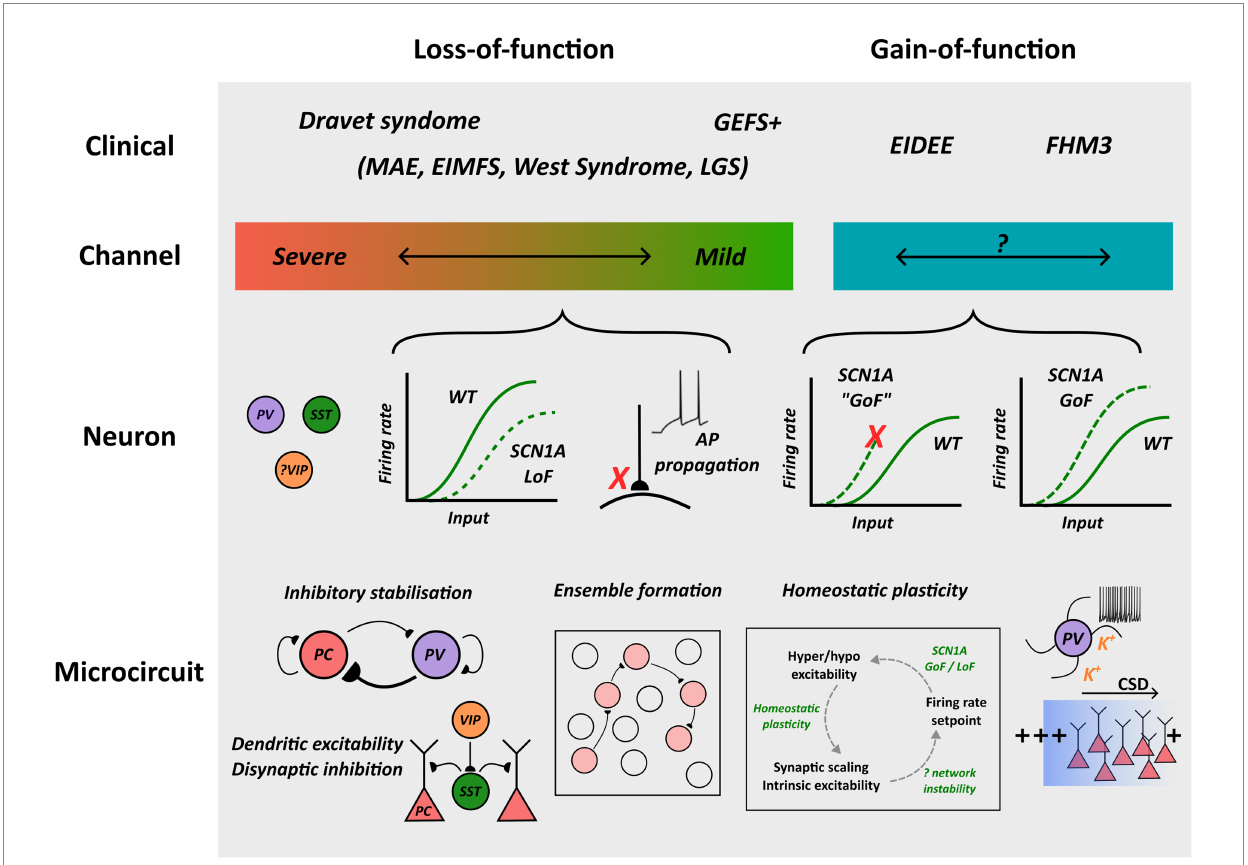
FIGURE 1 Overview of pathological mechanisms implicated in SCN1A channelopathies. Na V 1.1 loss and gain-of-function are associated with distinct clinical syndromes, and whereas profound loss-of-function is associated with Dravet Syndrome, an association between the extent of channel gain-of- function and clinical phenotype has been proposed but not confirmed. Loss-of-function can lead to interneuron hypo-excitability or impaired action potential propagation/transmission, and gain-of-function may enhance excitability or predispose to neuronal depolarization block. Although microcircuit-scale pathology remains to be fully elucidated, possible mechanisms contributing to cortical dysfunction are outlined. MAE: myoclonic astatic epilepsy; EIMFS: epilepsy of infancy with migrating focal seizures; LGS: Lennox–Gastaut syndrome; GoF: gain-of-function; LoF: loss-of- function; AP: action